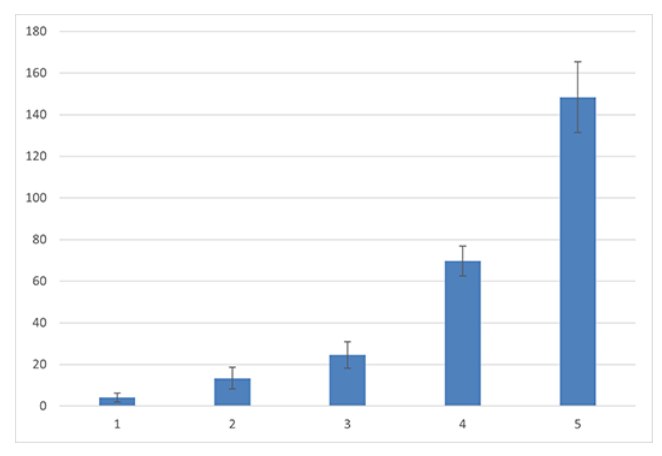
Figure 3 e number of the sporophytes regenerated from a single apical dome of Cyathea smithii cultured on hormone free 1/2 Murashige and Skoog agar medium (control – 1) or supplemented with 0.01 (2), 0.1 (3), 1.0 (4), or 5.0 (5) μM thidiazuron [TDZ;